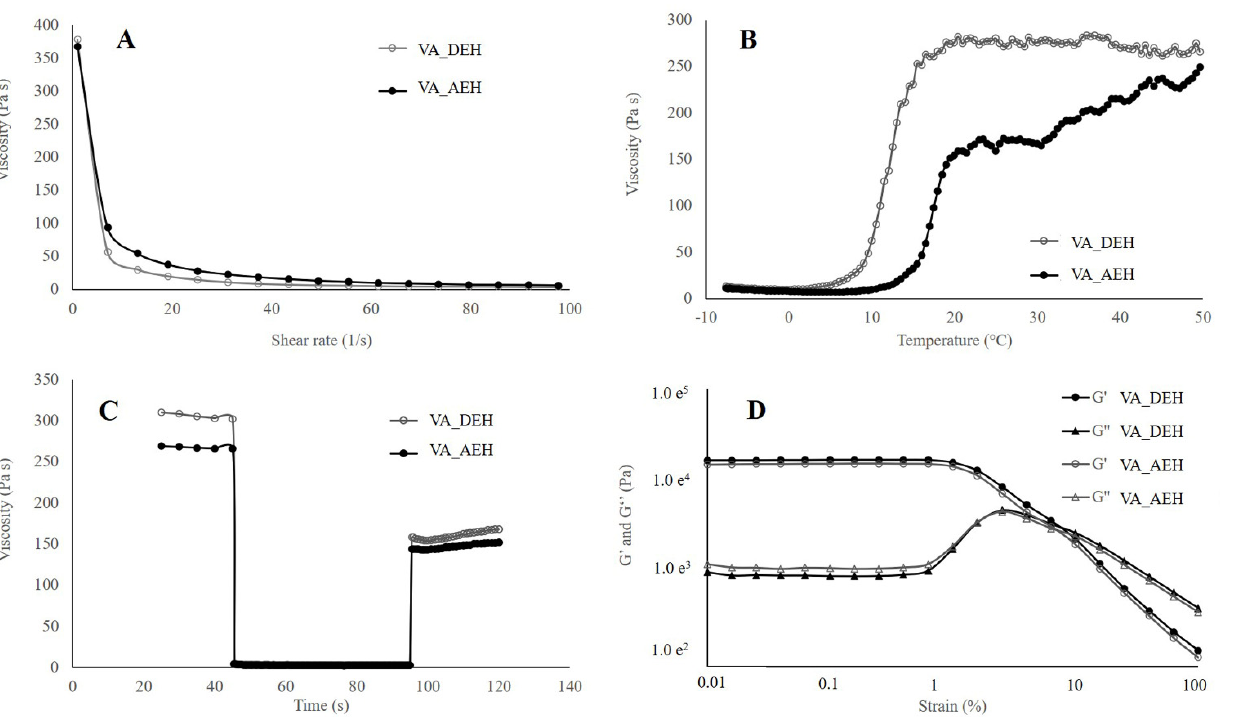
Figure 3. Rheological parameters of the hydrogel containing 5% w/w of V. album dry extract (VA_DEH) and aqueous extract (VA_AEH). ( A ) Apparent viscosity; ( B ) Temperature sweep; ( C ) Three-interval thixotropic test; ( D ) Strain sweep (G’—elastic module; G”—viscous module).